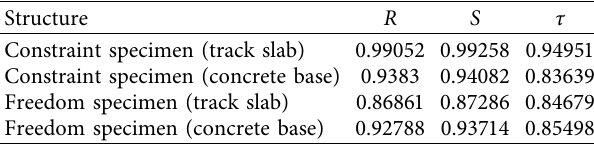
Table 6: Calculated results of the correlation